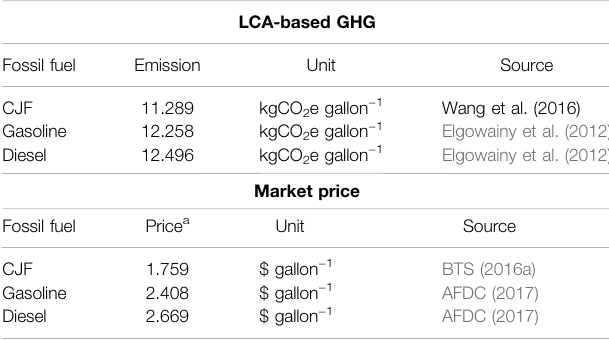
TABLE 2 | Parameters on energy-equivalent substitutes to ATJ products.